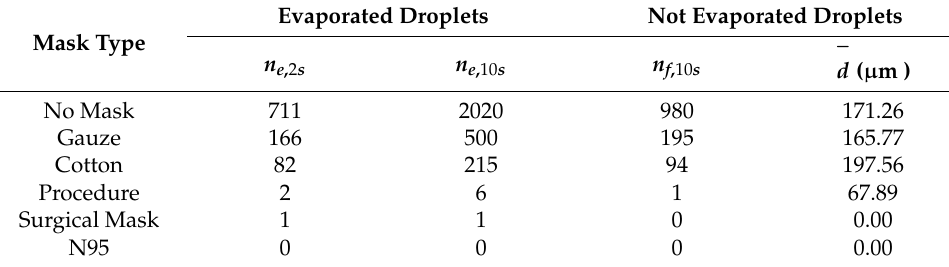
Table 4. Diameter reduction for determining evaporation state at a specific timestamp.